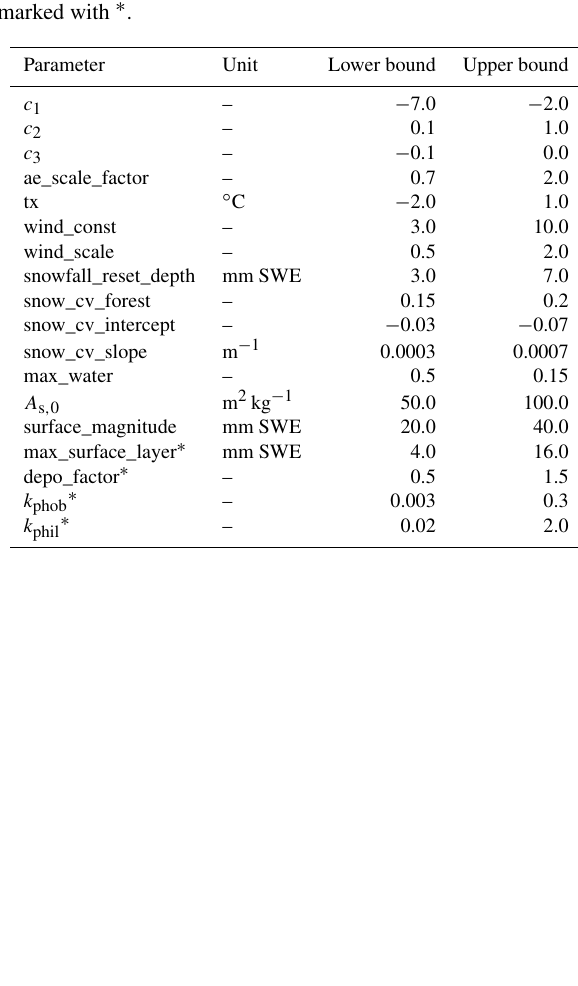
Table B1. Model parameter bounds used in the uncertainty estima- tion with the GLUE method. Parameters used to determine ARF are marked with ∗